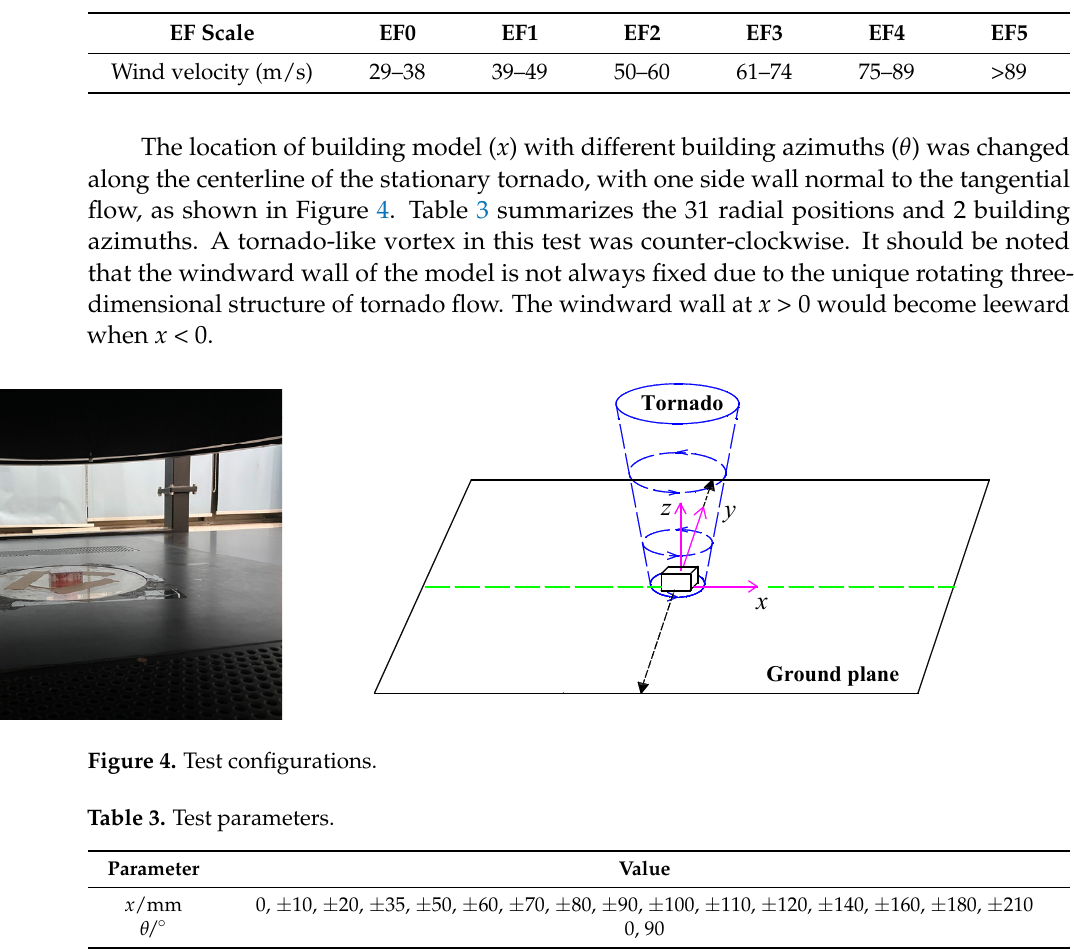
Table 2. Enhanced Fujita scale of tornadoes.